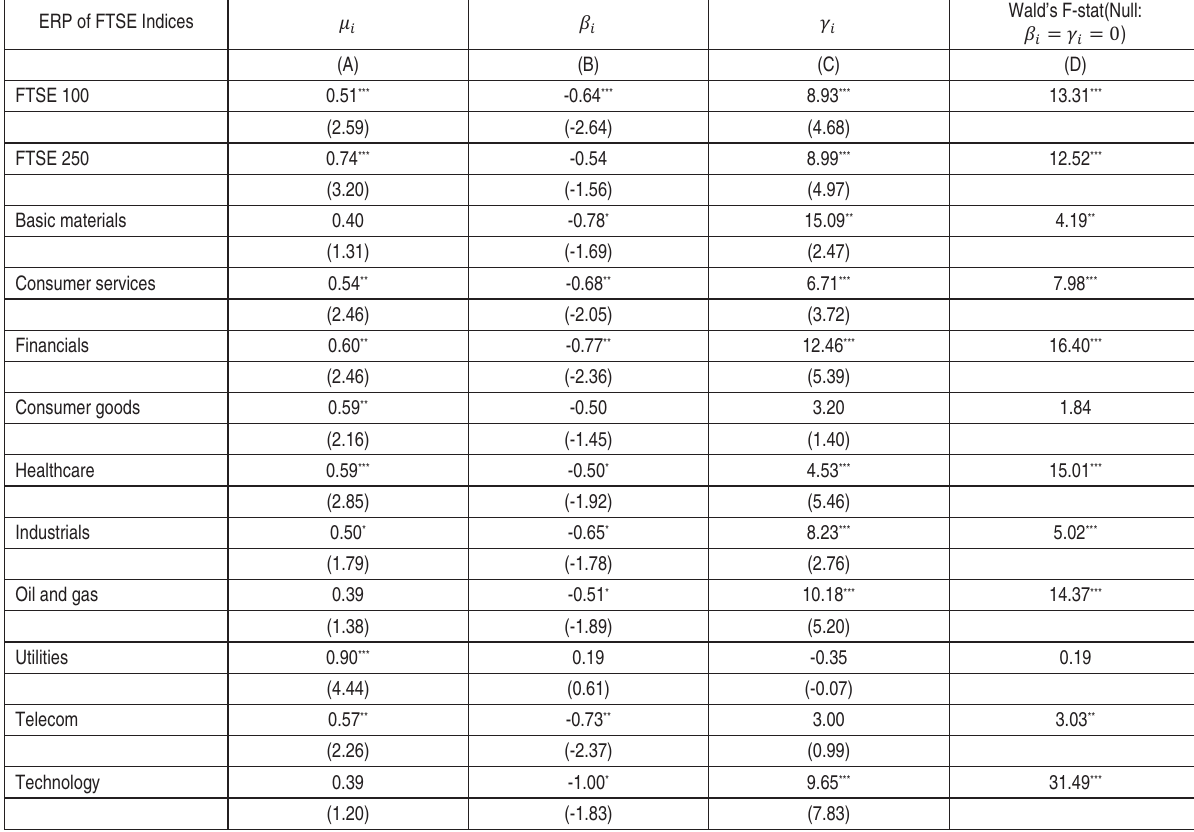
Table 6. The impact of monetary policy shocks on ERP using base rate as monetary policy instrument.